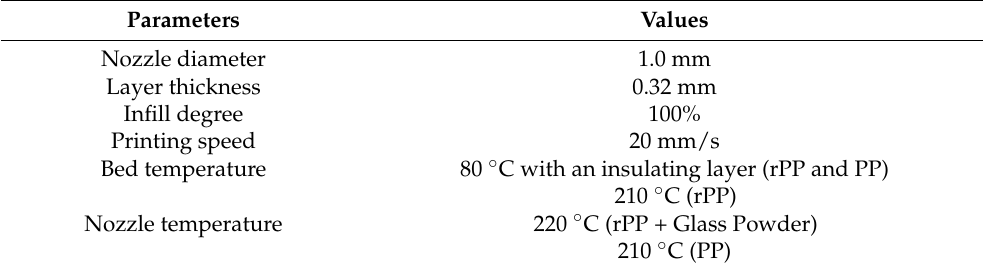
Table 3. Printing parameters for rPP, PP, and PLA filaments.